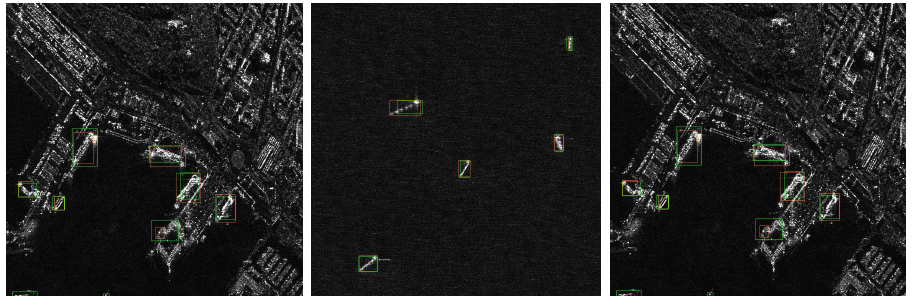
Figure 1. The problem of ship object detection.